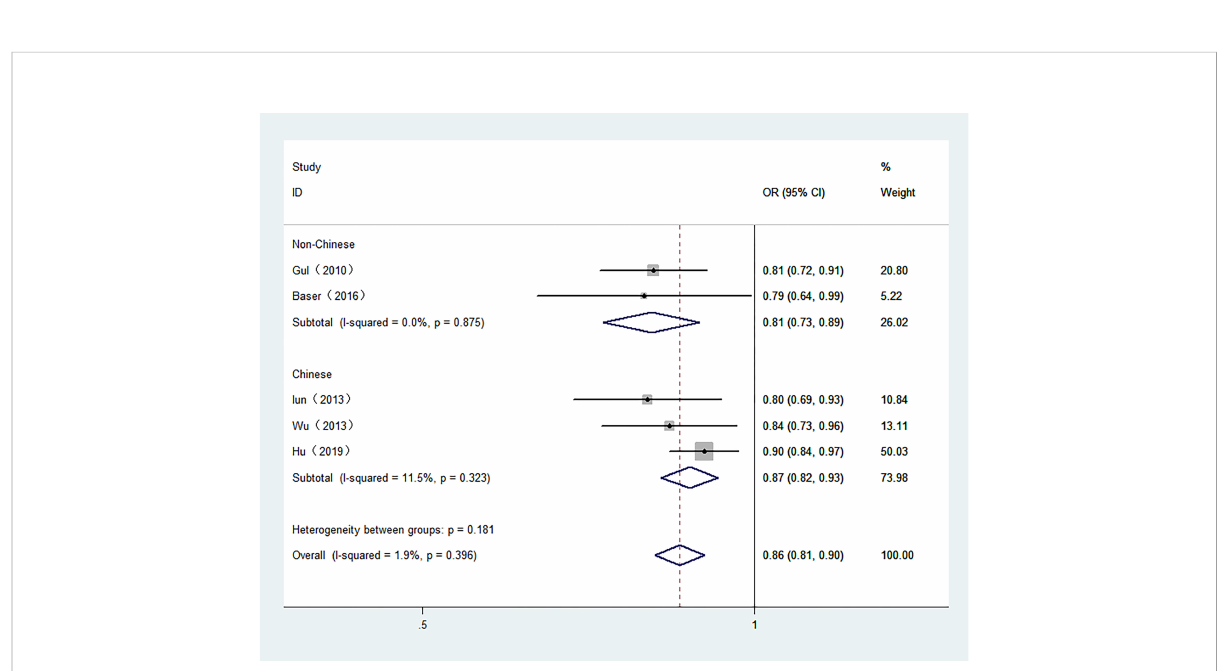
FIGURE 3 Forest plot of the risk of TC associated with FT3. Hollow diamonds represent pooled OR. Error bars indicate 95%